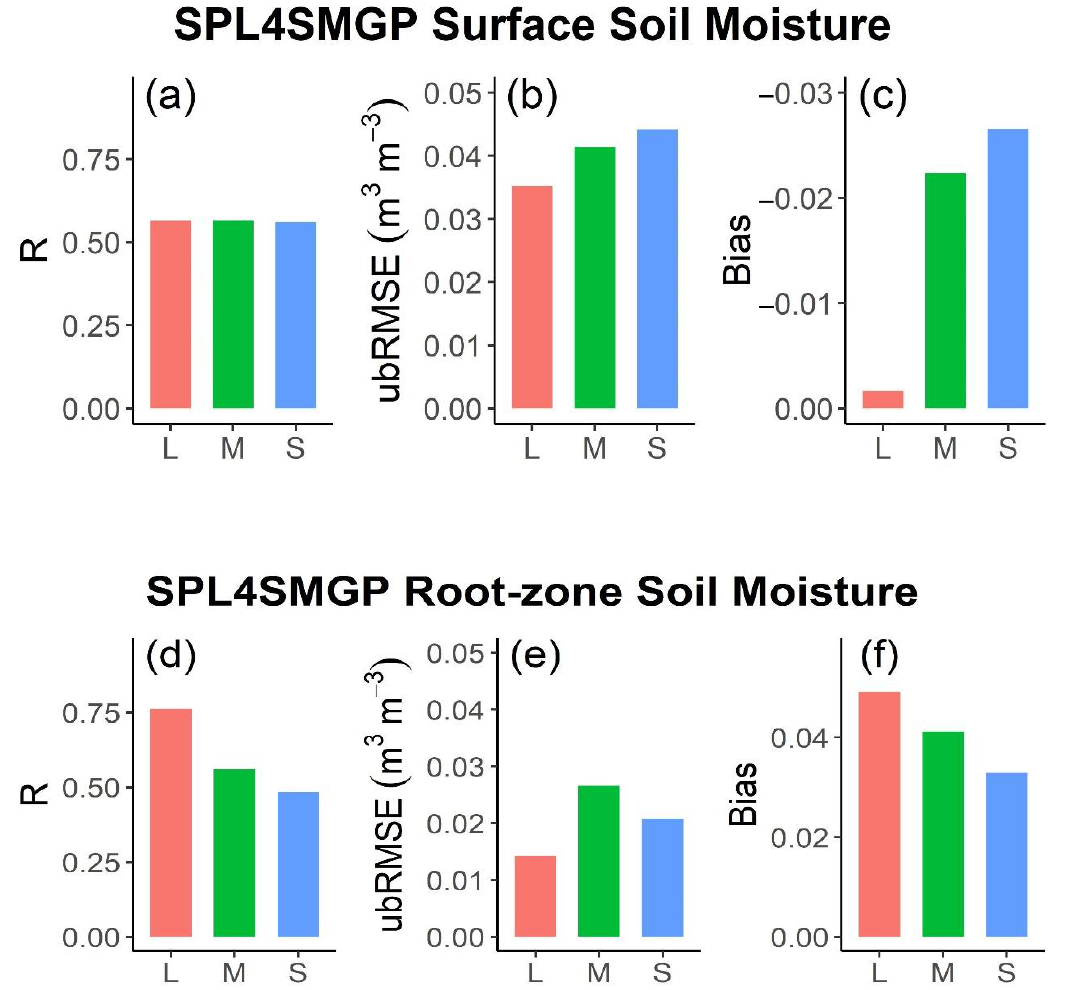
Figure 4. Performance metrics (R ( a , d ), ubRMSE ( b , e ), bias ( c , f )) for SPL4SMGP SSM (top row) and RZSM (bottom row) retrievals at S-scale, M-scale, and L-scale stations. In the end, the averaged ubRMSE value of all the in situ stations for RZSM (0.017 m 3 /m 3 ) was considerably lower than that of the SSM value (0.037 m 3 /m 3 ) (Figure 5b). As previously stated, this was simply due to the lower temporal variability in RZSM. The